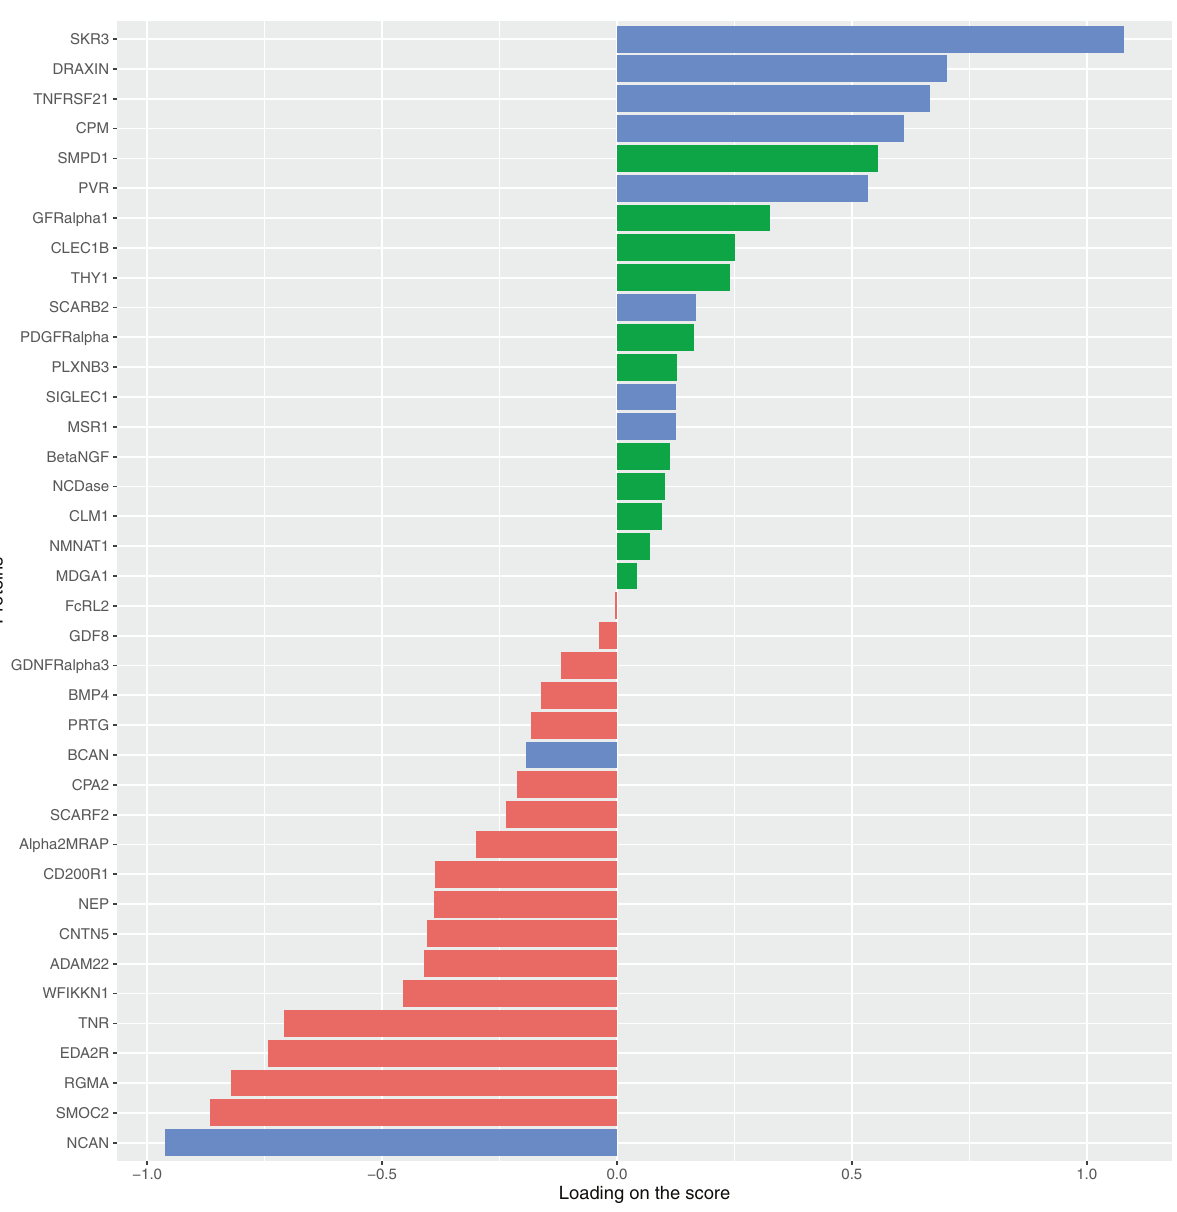
Fig. 1 Proteins retained in the multiprotein composite score. Replicated proteins from bivariate analyses of PTSD symptom severity and PTSD diagnosis are denoted by the blue